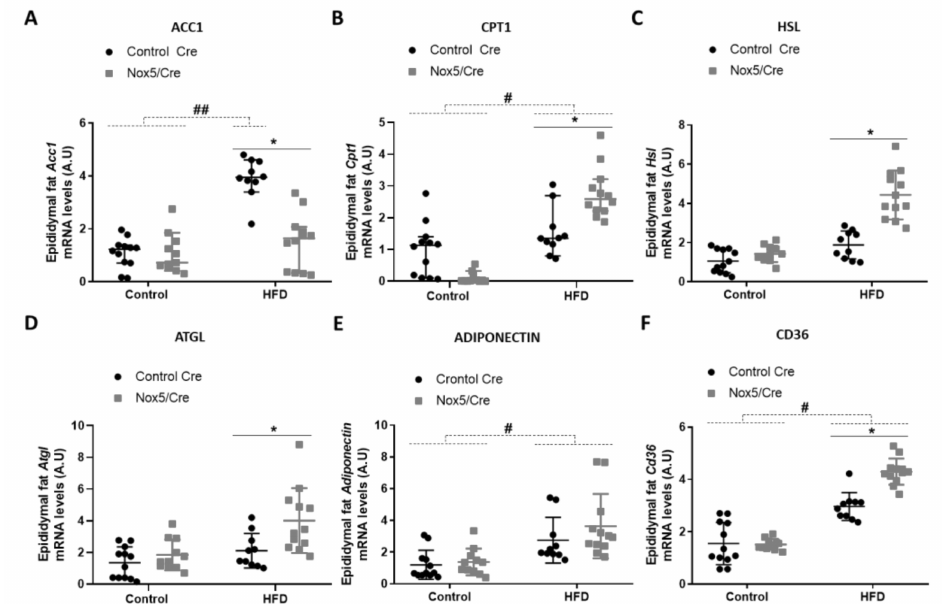
Figure 3. Endothelial NOX5 expression decreased Acc1 expression and increased Cpt1 , Hsl , Atgl , and Cd36 mRNA expression in epididymal fat in mice fed a HFD for 10 weeks. ( A ) Acc1 mRNA levels. ( B ) Cpt1 mRNA levels. ( C ) Hsl mRNA levels. ( D ) Atgl mRNA levels. ( E ) Adiponectin mRNA levels. ( F ) Cd36 mRNA levels. Control diet: control Cre ( n = 12), Nox5/Cre ( n = 11); HFD: control Cre ( n = 10), Nox5/Cre ( n = 12). Results are expressed as median with confidence interval. mRNA levels are relative to Gapdh . # p <0.05, ## p < 0.01: diet differences (dotted lines); * p < 0.05: genotype differences (solid lines). Statistical test used: Aligned Rank